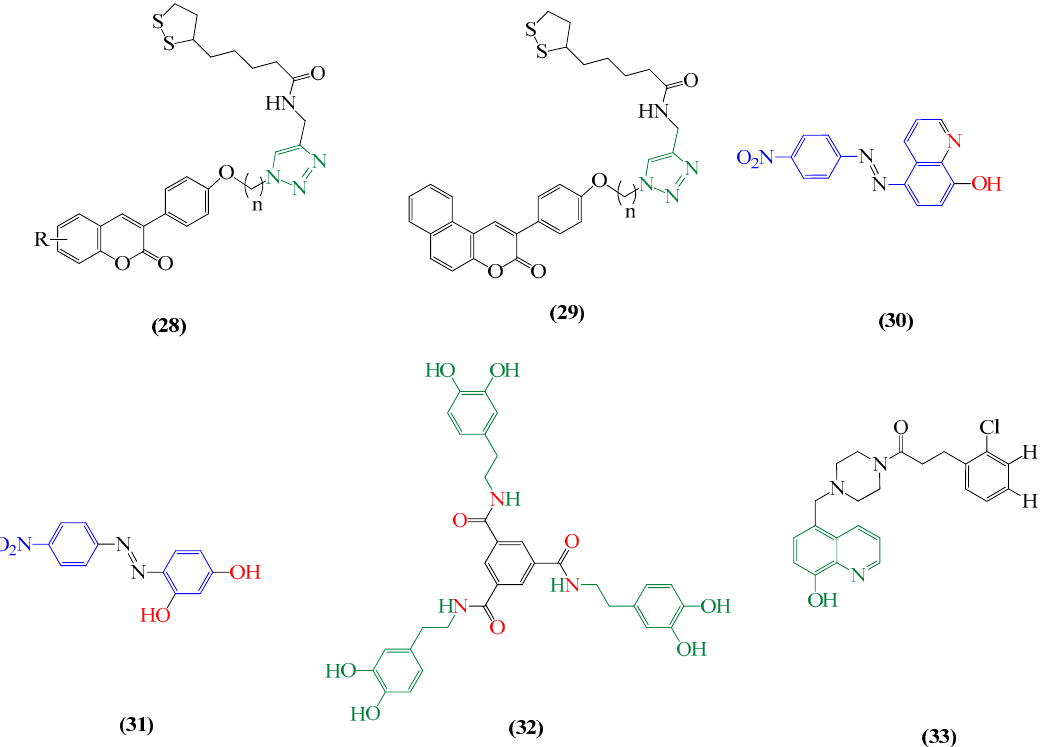
Figure 10. Chemical structures of the multifunctional compounds for ND disease treatment. 15 is the clioquinol molecule, 5-chloro-7-iodo-quinolin-8-ol 28 and 29 are 3-arylcoumarines derivatives, 30 is 5-((4-nitro-phenyl)diazenyl)quinolin-8-ol (HL1), 31 is the 4-((4-nitrophenyl)diazenyl)benzene-1,3-diol (HL2), 32 is the tris(dopamine) derivative benzene-1,3,5-tricarboxylic acid tris-{[2-(3,4-dihydroxy- phenyl)-ethyl]-amide} and 33 is an 8-hydroxyquinoline derivative 3-(2-chloro-phenyl)-1-[4-(8-hydroxy-quinolin-5-ylmethyl)-piperazin-1-yl]-propan-1-one.